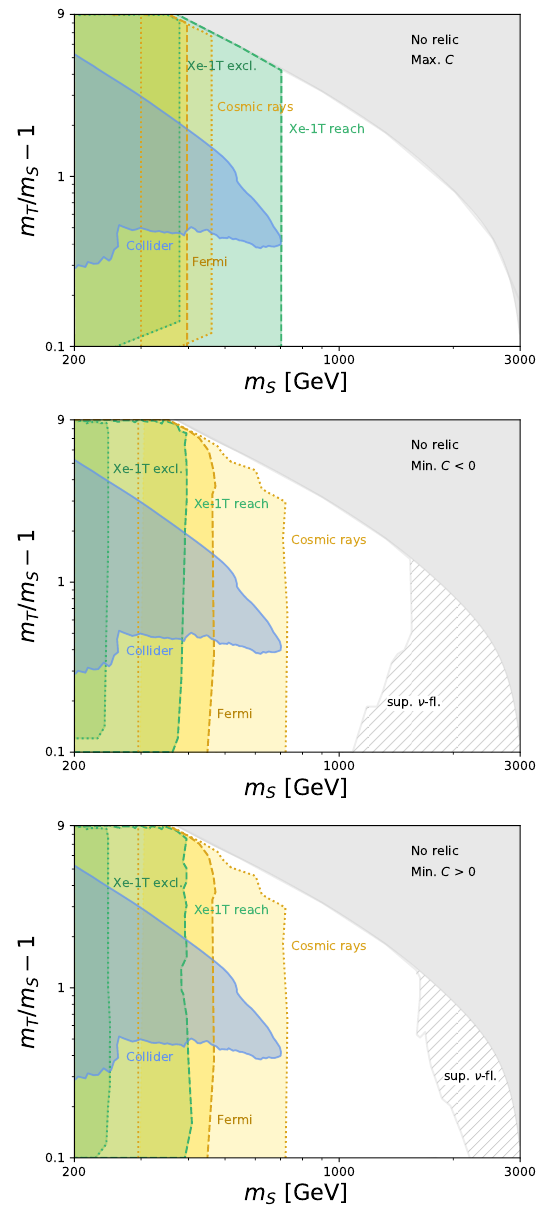
Figure 9 . Exclusions and projected reaches on the considered top-philic scalar DM model. Our results are presented in the ( m S , r = m T /m S − 1) plane and include collider (blue), as well as DM direct (green) and indirect detection (yellow) constraints. For the area in grey, there is no combination of the other model parameters that yields the right relic density. For the other, viable, scenarios, we make three choices to present the results. In the top row, we consider the largest possible value of the Wilson coefficient allowing to recover the measured relic density for given m S and m T values, whilst in the central and bottom rows we choose instead the smallest C/ Λ value, either with a positive sign (lower row) or a negative one (central row). These figures summarise the findings already presented in figures 4, 6, and